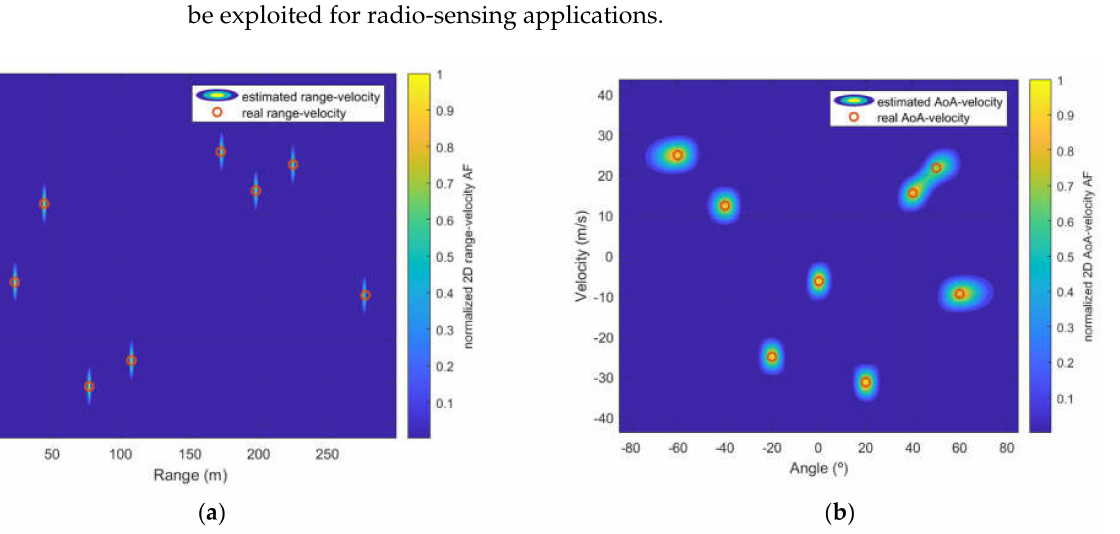
Figure 5. Radar imaging obtained for Alamouti SFBC and eight receiver antennas, ( a ) normalized 2D range-velocity AF obtained for targets in Table 2, ( b ) two-dimensional AoA-velocity AF obtained for targets in Table